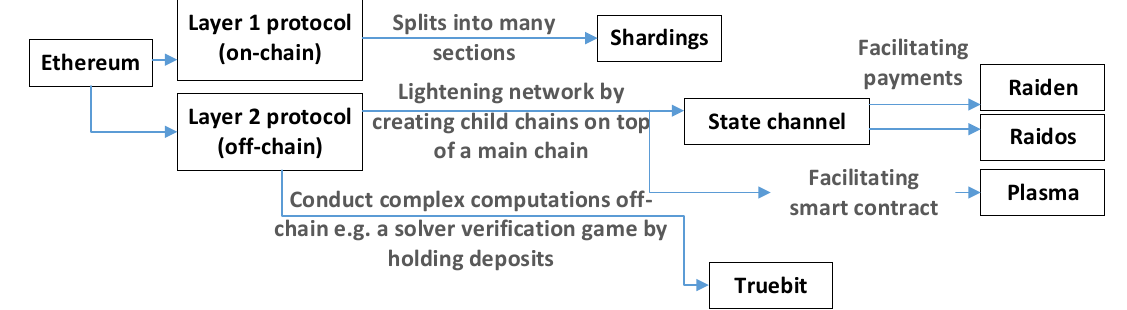
Figure 4. Public Ethereum protocols (developed by the author).